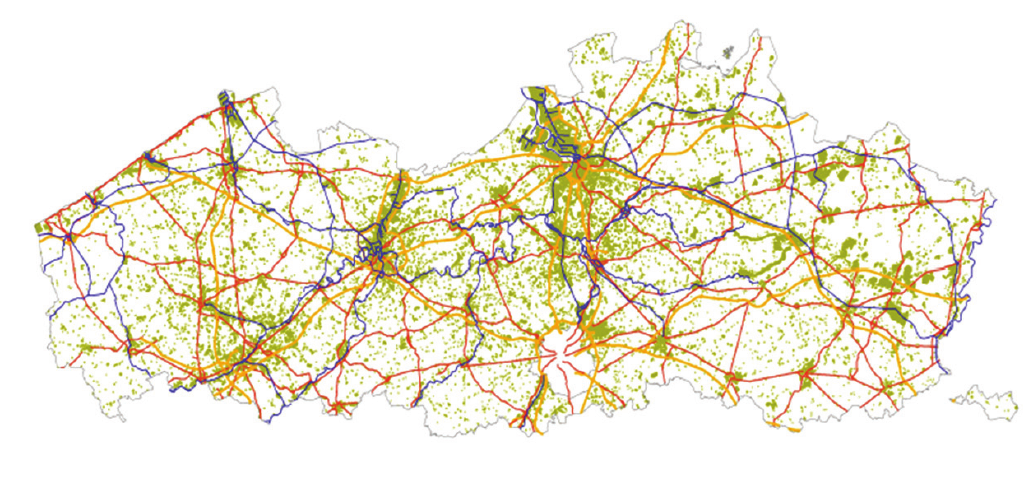
FIGURE 1. Explored contaminated sites in Flanders from the Land